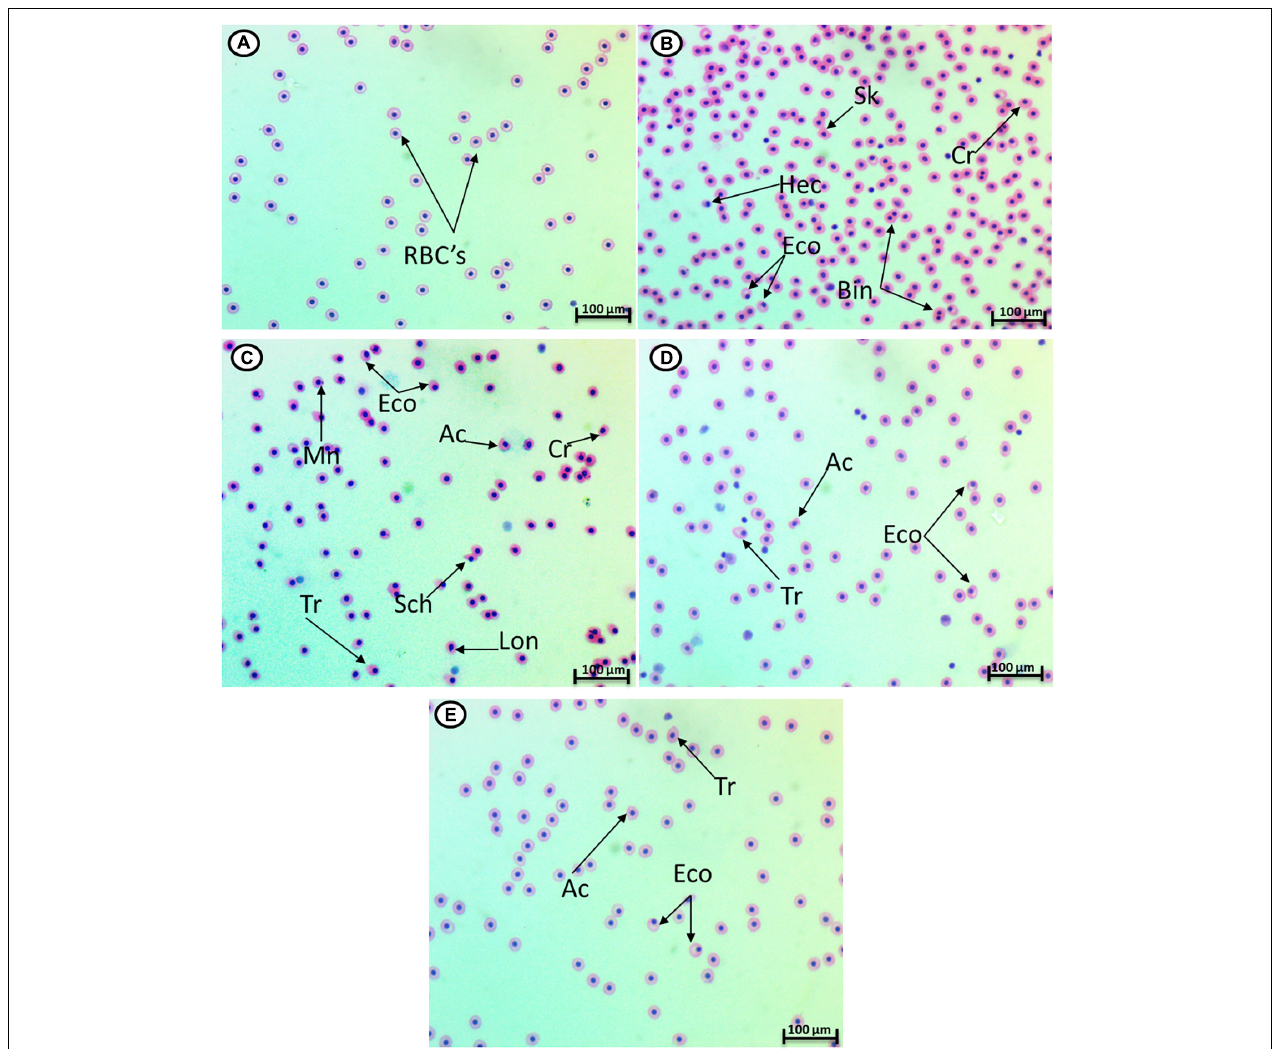
FIGURE 2 | Hematoxylin–eosin-stained blood smears from catfish showing I: the normal erythrocytes (A) , the deformed ones after exposure to hydroxychloroquine for 15 days (B,C) , the deformed ones after exposure to hydroxychloroquine + 10 mg/l Spirulina for 15 days (D) , and the deformed ones after exposure to hydroxychloroquine + 20 mg/l Spirulina for 15 days (E) . Tr, tear-drop cell; Cr, crenated cell; Ac, acanthocyte; Eco, eccentric nucleus; Hec, hemolyzed cells; Mn, micronucleus; Bin, bionuclei; Lon, lobed nucleus; Shc, schistocytes; Sk, sickle cell (magnification: 1,000 ×